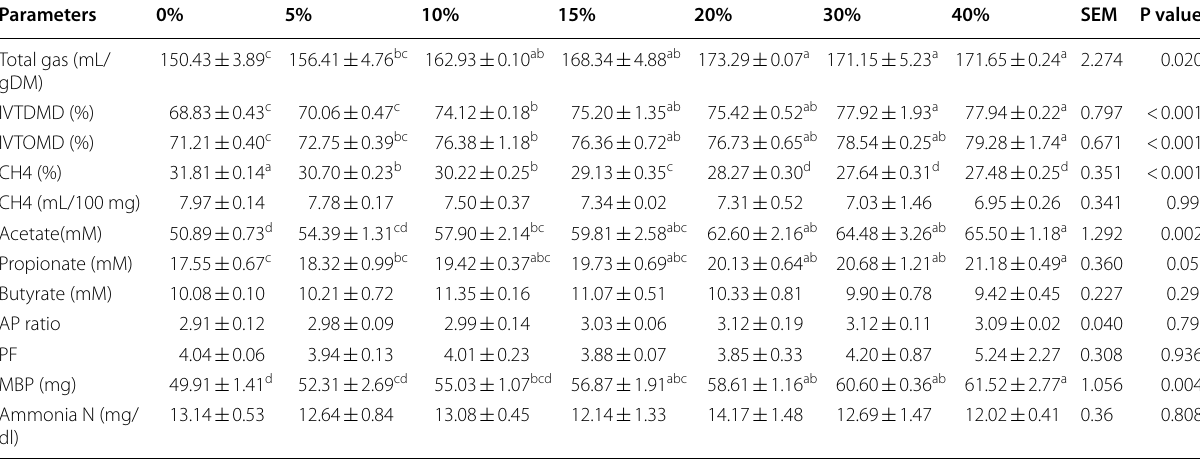
Means with different superscripts a, b, c and d in the same row differ significantly ( P <